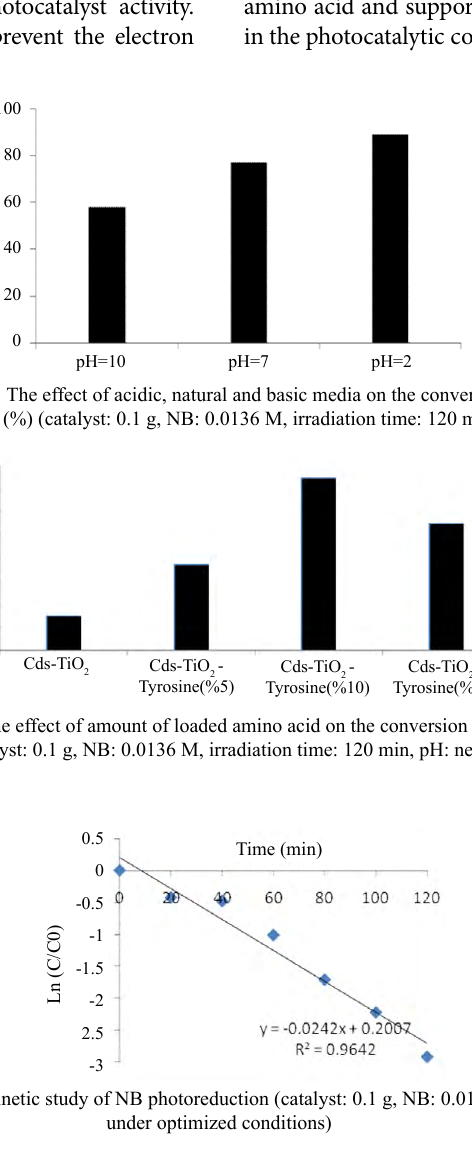
Fig. 12. Kinetic study of NB photoreduction (catalyst: 0.1 g, NB: 0.0136 M, under optimized conditions)